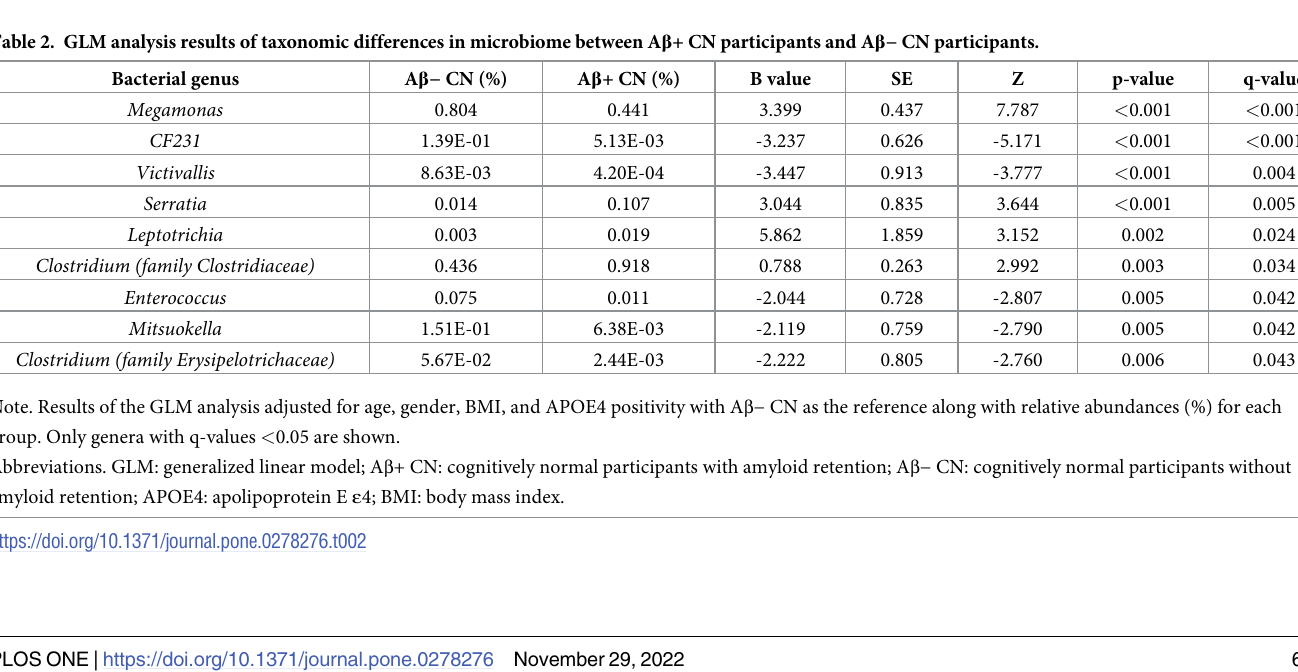
Comparison of predicted functional microbiome pathways With regard to the KEGG functional pathways predicted using PICRUSt, a decrease in the pathway (i.e., gene contents) related to genetic information processing was found in the A β + CN group compared to the A β − CN group in level 1 (Fig 3). In level 2, pathways related to translation and to cell growth and death were decreased in A β + CN, whereas those related to cellular processes and signaling and to metabolism of other amino acids were increased com- pared to A β − CN (Fig 3 and S1 Table).